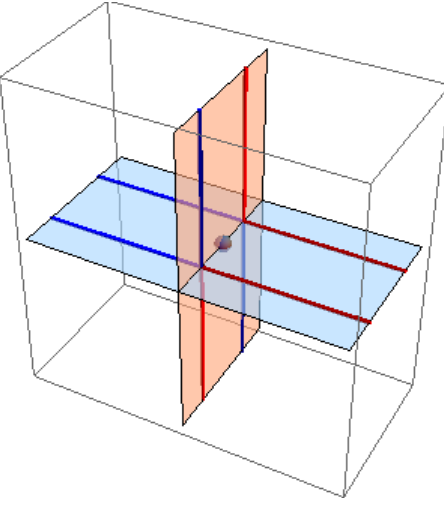
Figure 5: The vertices at the two ends of this edge have been decomposed in incom- patible ways. When each vertex is pulled apart into different topologically distinct surfaces by picking one of the options in e.g. Figure 4, the individual faces emanat- ing from the vertex are joined pairwise in a particular manner. Here the red lines both belong to one such surface and the blue lines to another. The resulting incom- patibility requires us to add a branch point (grey dot) along the edge to rejoin the